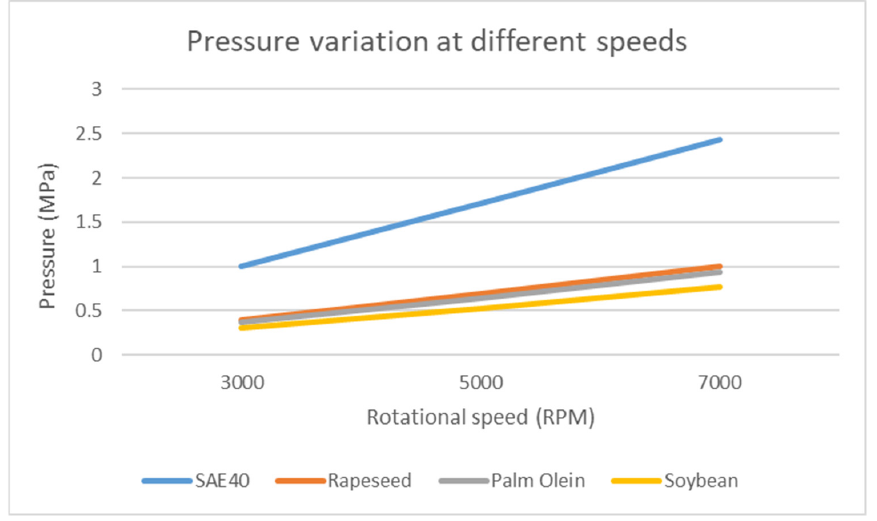
Figure 10. Effect of RPM on hydrodynamic pressure (ANSYS Fluent).